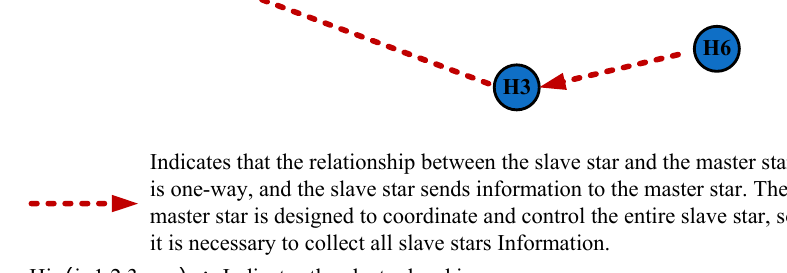
Figure 5. Master-slave relationship